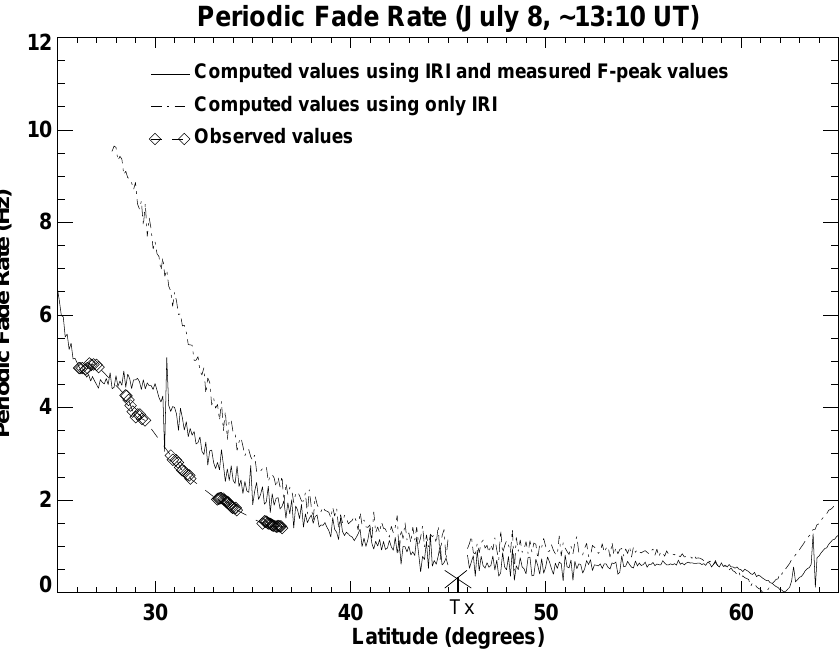
Fig. 2. An example comparison between simulated and observed Faraday fade rates. This pass occurred on 8 July 1978, 13:10 UT. The two computed curves were obtained using two different electron density profiles, one generated using only the IRI model and the other using the model scaled to the topside sounding fo F2